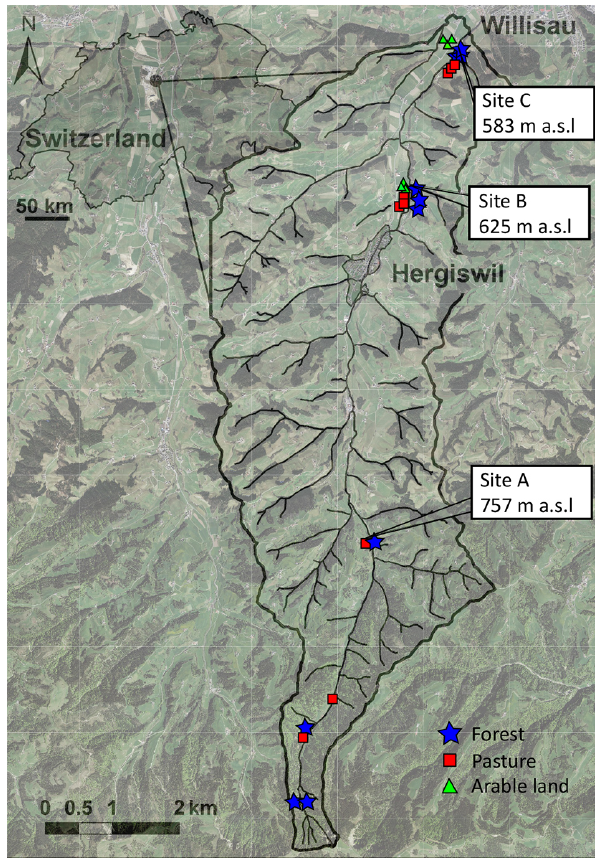
Figure 1. The Enziwigger catchment (Canton Lucerne, Switzer- land) with the three suspended sediment sampling sites A, B, C and location of the source soil sampling spots forest, pasture and arable